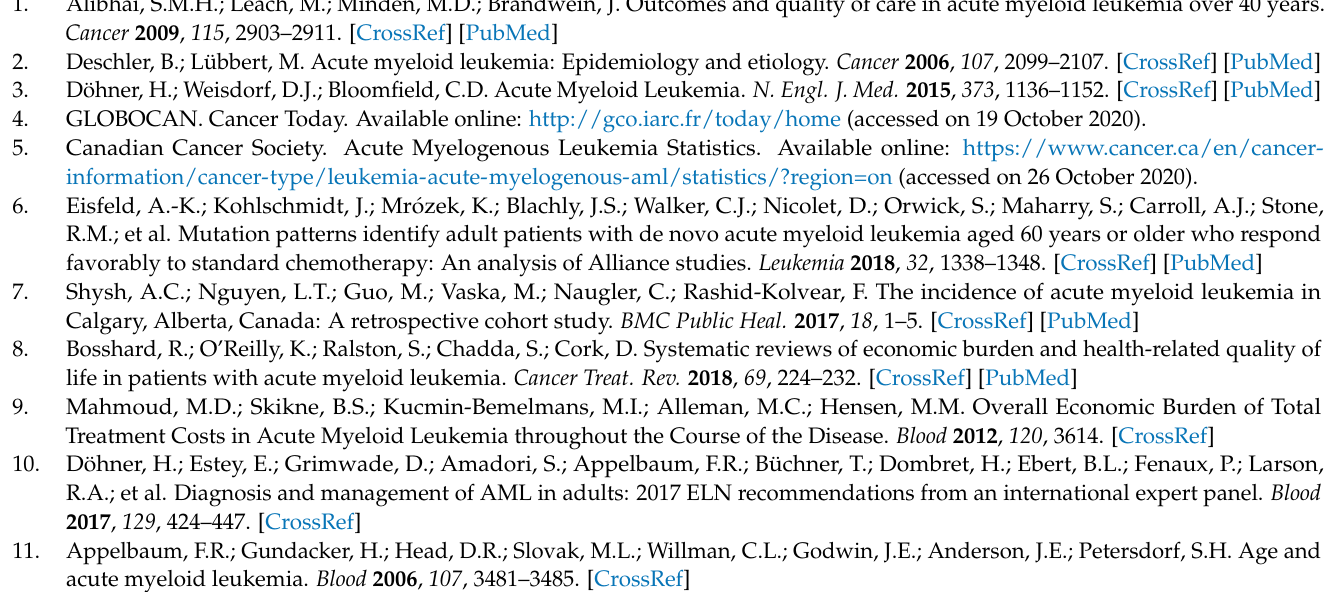
for Oral Therapies; Table S3: Administration Cost Parameters for IV Therapies; Table S4: Ad- ministration Costs per Treatment; Table S5: Unit Costs of Hospitalization and Blood Transfusion; Table S6: Health Care Resource Utilization by Health State; Table S7: Grade 3/4 AEs ≥ 5% for Each Treatment; Table S8: Follow-up Costs; Table S9: Follow-up and Monitoring Frequency by Health State; Table S10: Follow-up and Monitoring Costs by Health State; Table S11: Costs of Terminal Care; Table S12: Indirect Cost Parameters; Table S13: Employment Rate. References [60–62] are citied in the Supplementary